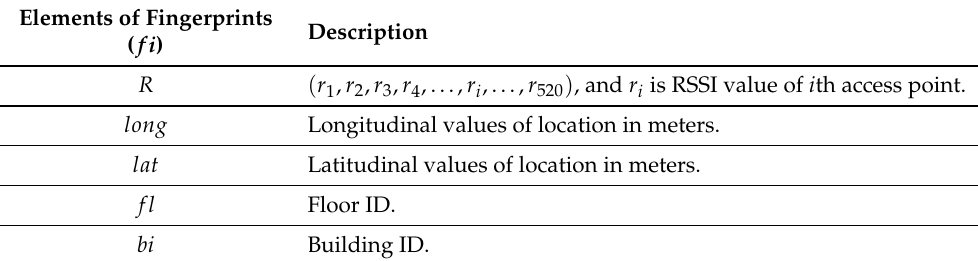
Table 2. Elements of fingerprints in